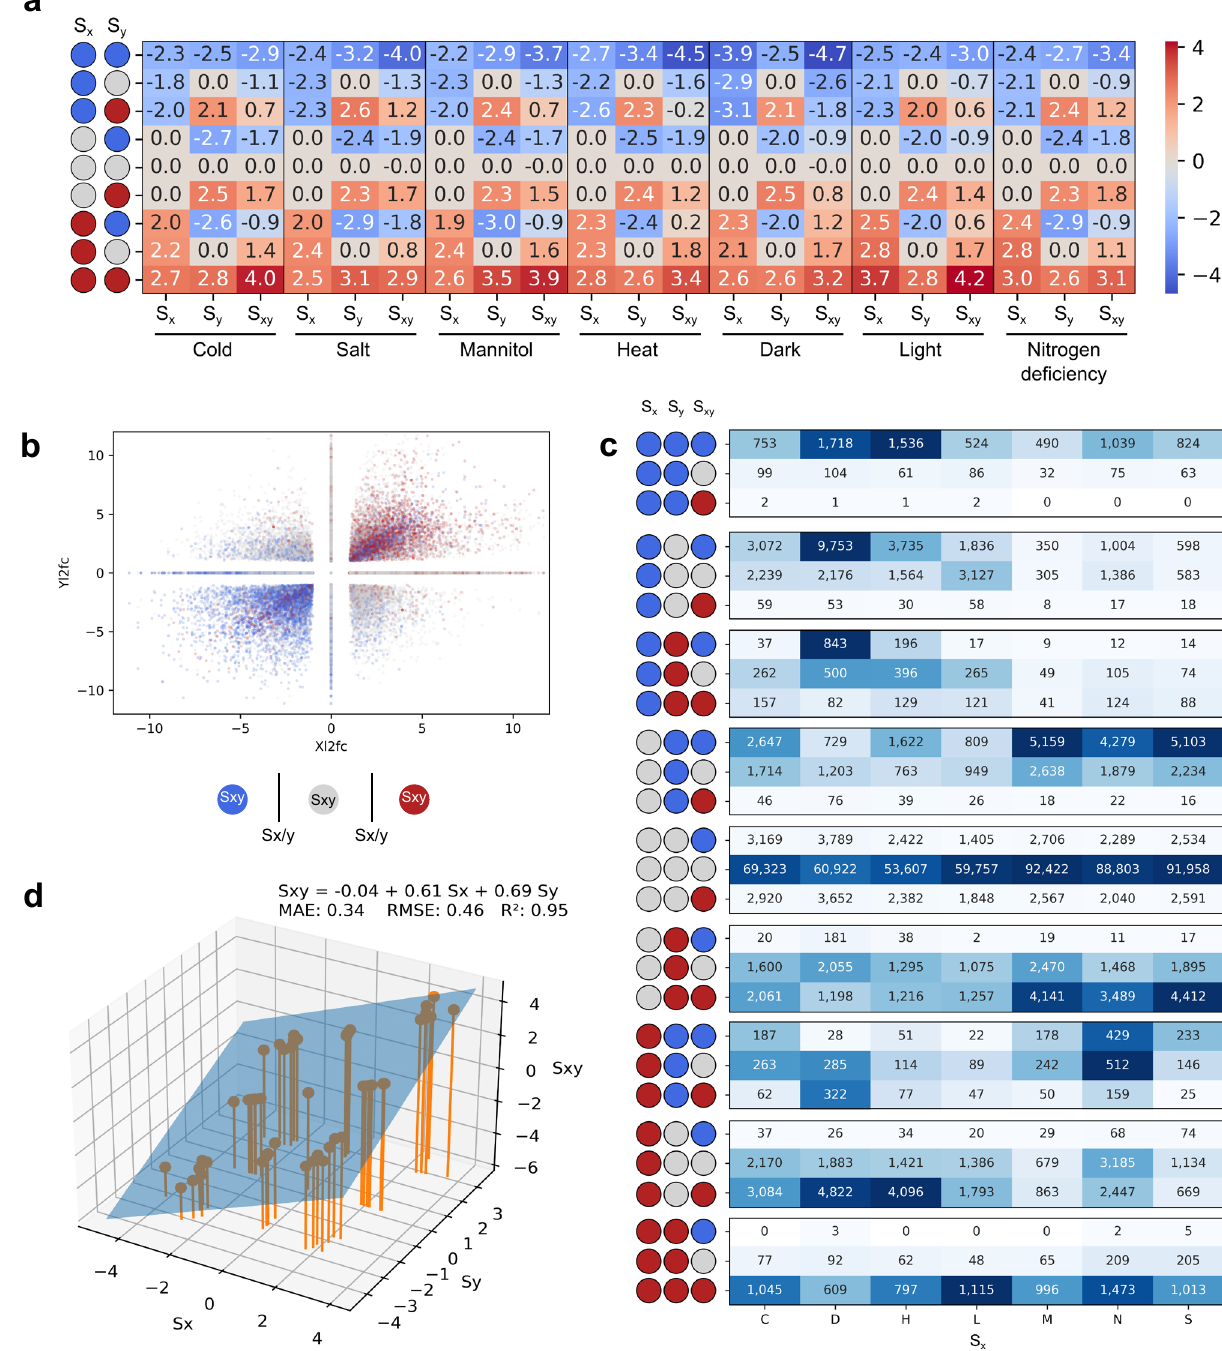
Fig. 6 | Analysis of gene expression responses in combined stress. a Averaged log 2 fcofgenesinS x (typeofstressindicatedatthebottom),S y (otherstresses),and S xy (combined stress). Blue, red, and gray circles indicate genes that are sig- ni fi cantly downregulated, upregulated, and not changed, respectively. b Scatter plot depicting the outcome in combined stress, where red, blue, and gray dots indicatethattheresponseishigher,lower,orwithintherangeofthesinglestresses, respectively. c Break down of the response observed in combined stress S xy . The